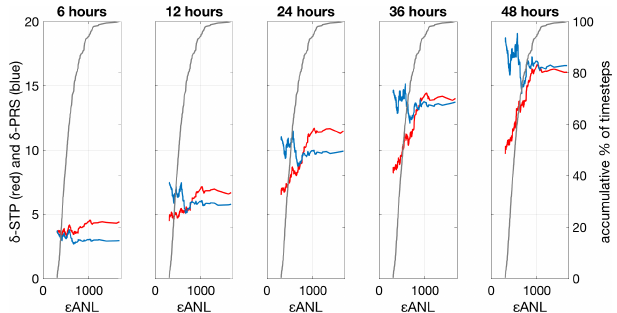
Figure 7. The left y axis indicates δ STP (red) and δ PRS (blue) for the corresponding ε ANL after 6, 12, 24, 36, and 48h. The right y axis is the cumulative percent of time steps in the computation of the mean errors, as indicated by the black line in the plots. The x axis is the ε ANL , ordered from minimum to maximum, for the best analog for the test year 2015 (BoB HFR system).